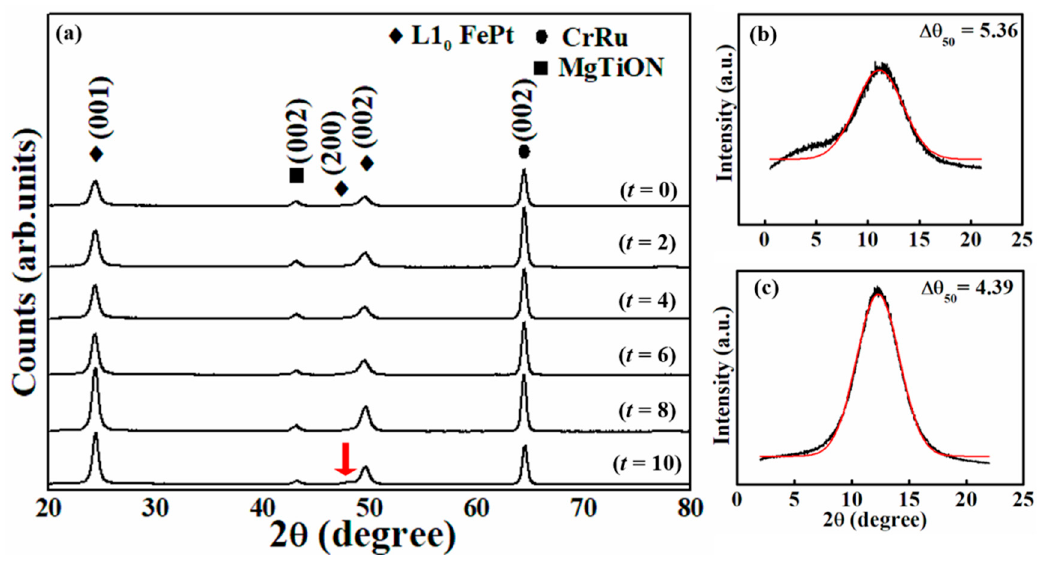
Figure 1 . XRD of the FePt(t nm)/[MgTiTaON(1nm)/FePt(4nm)] 2 /MgTiON/CrRu, ( a ) t = 2–10 nm, Rocking curves of ( b ) t = 0 nm, and ( c ) t = 10 nm.